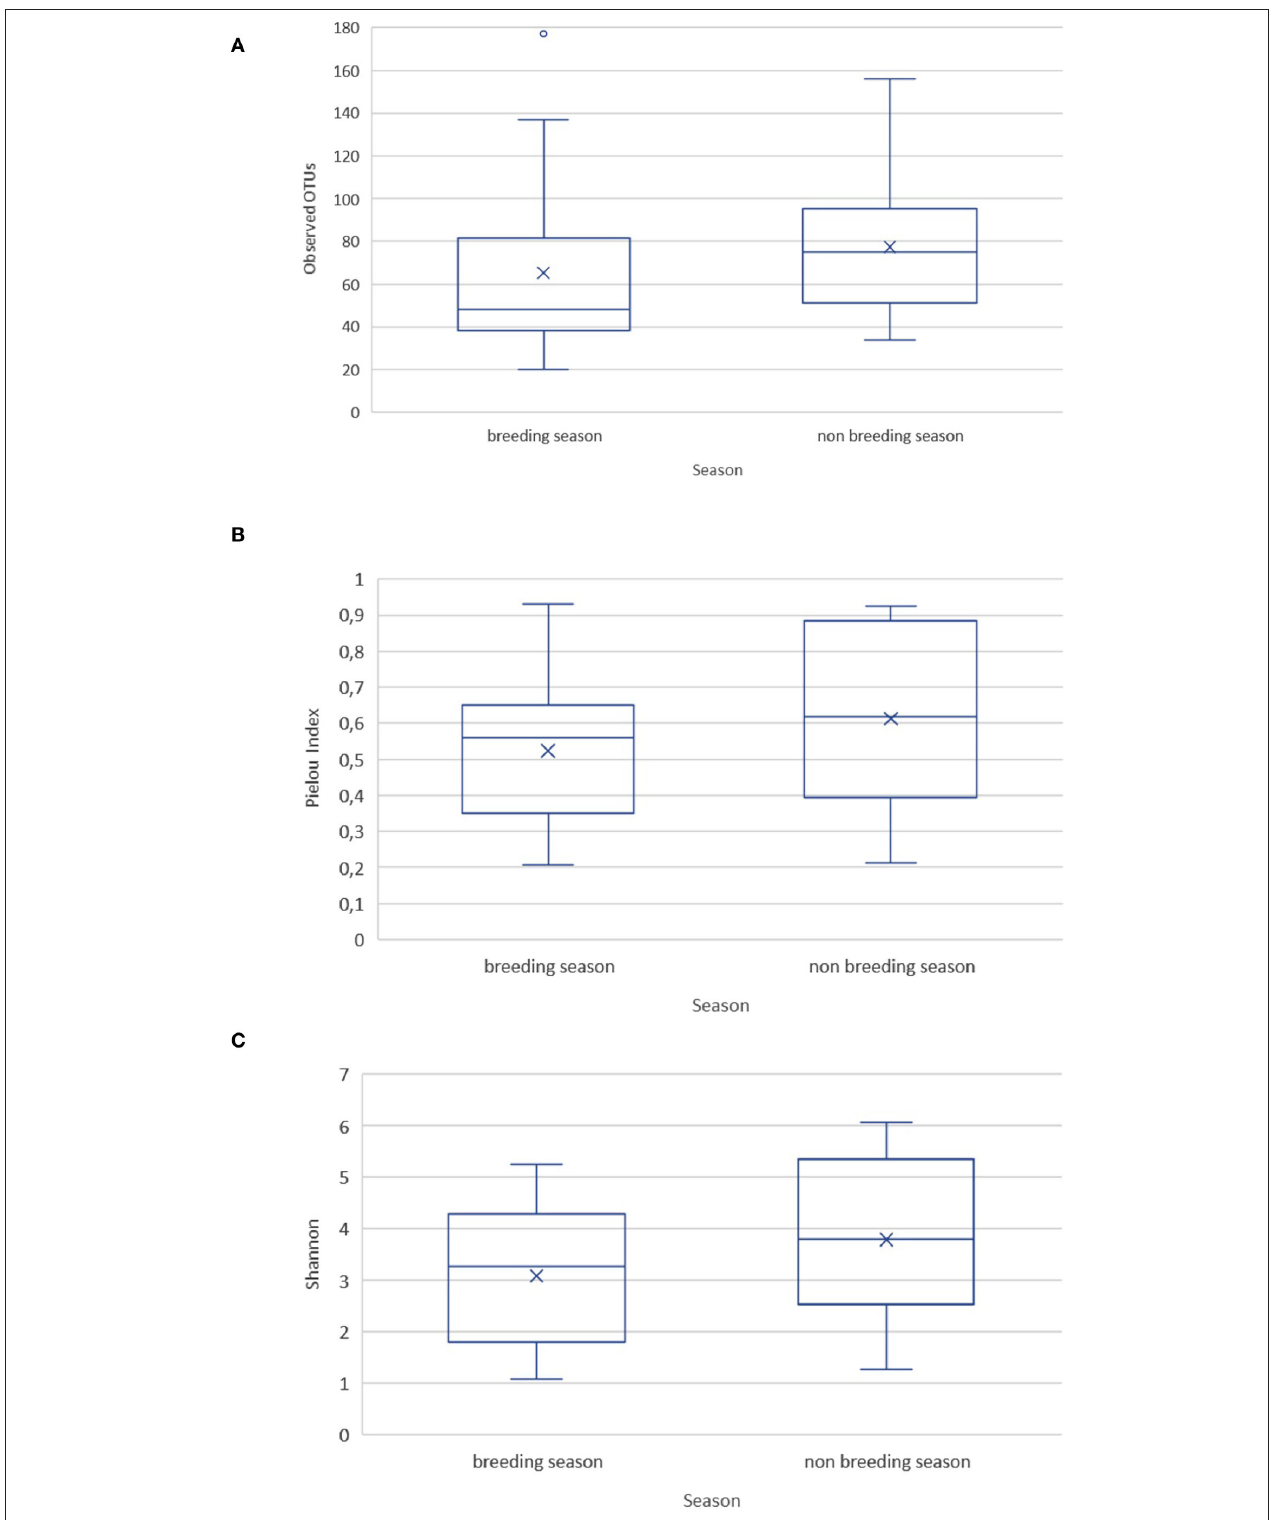
FIGURE 1 | Alpha diversity metrics for the goat buck ejaculates collected during the breeding and non-breeding seasons. (A) Observed OTUs; (B) Pielou’s evenness index; (C) Shannon’s diversity index.